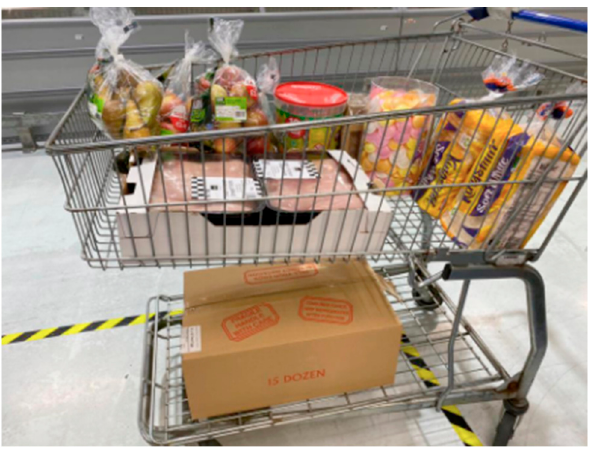
Figure 9. Khadijah’s shopping for charitable “care packs” (Khadijah, Diary Image, Entry 4).